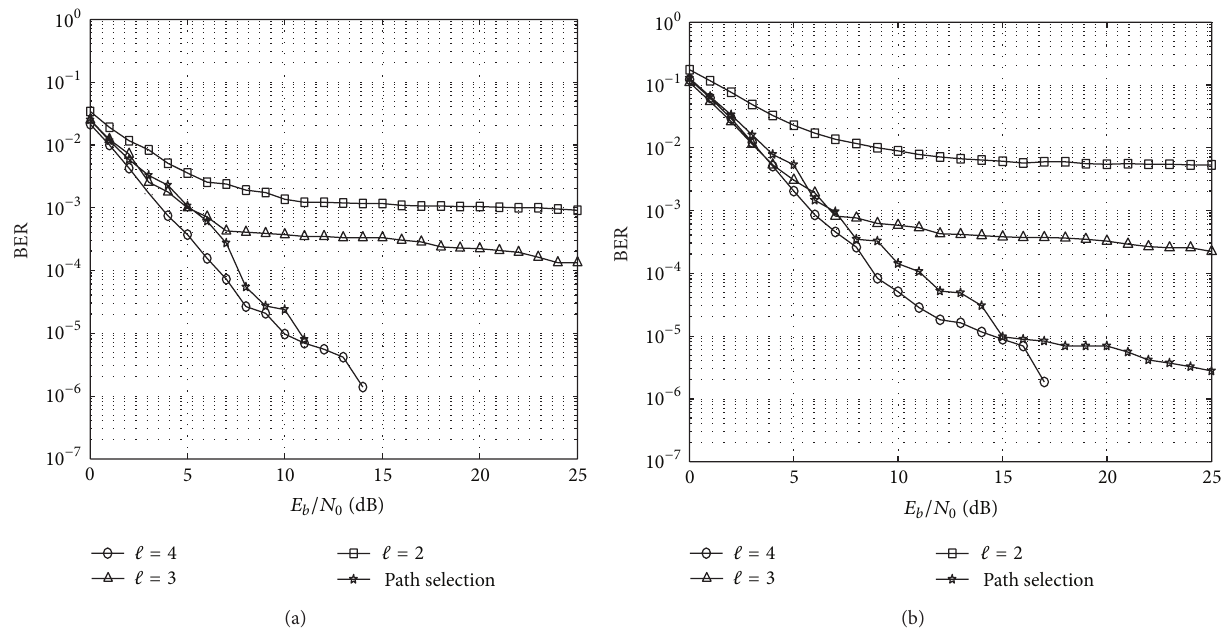
Figure 4: BER performance of 2 × 2 SFBC-OFDM system over the six-path fading channel with 26 nsec delay spread for (a) 16-QAM modulation and (b) 64-QAM modulation.